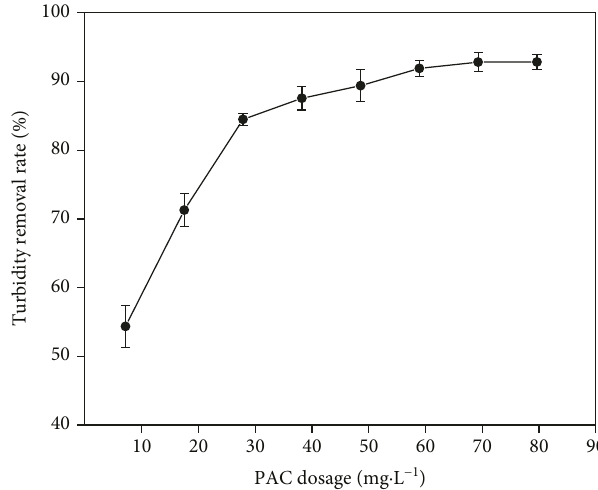
Figure 6: E ff ect of PAC on fl occulation